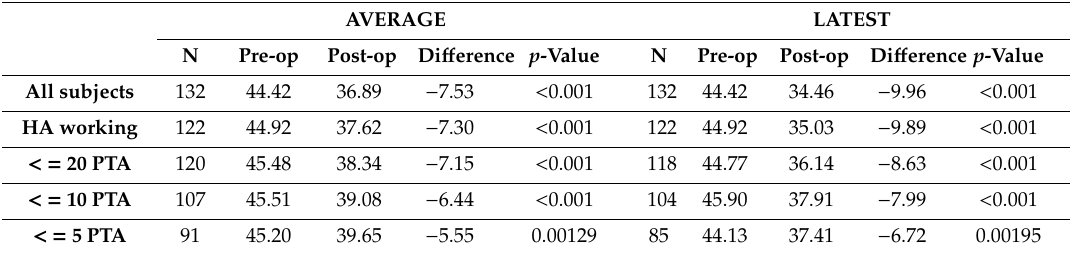
Table 3. Preoperative and postoperative speech perception scores in the nonimplanted ear (% correct). AVERAGE